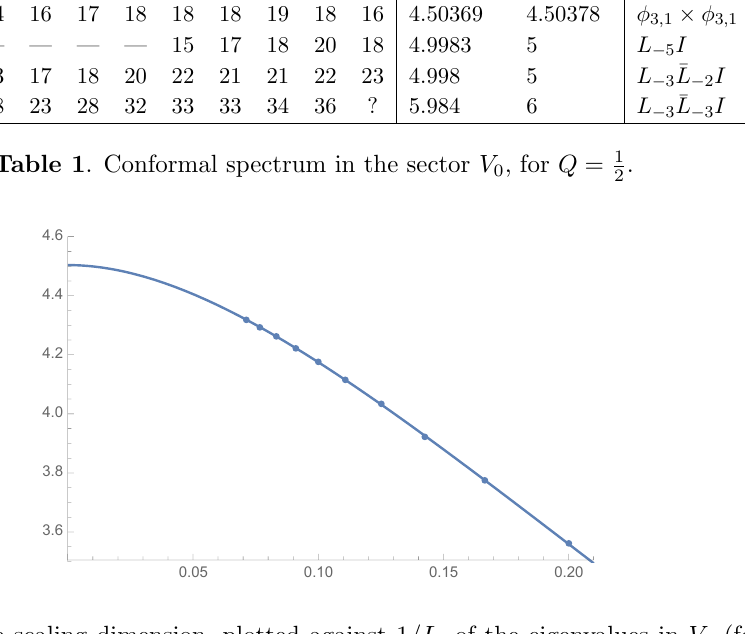
Figure 8 . E(cid:11)ective scaling dimension, plotted against 1 =L , of the eigenvalues in V 0 (for Q = 1 that correspond to the CFT scaling level (cid:30) 3 ; 1 (cid:2) (cid:30) 3 ; 1 , along with a polynomial extrapolation of order